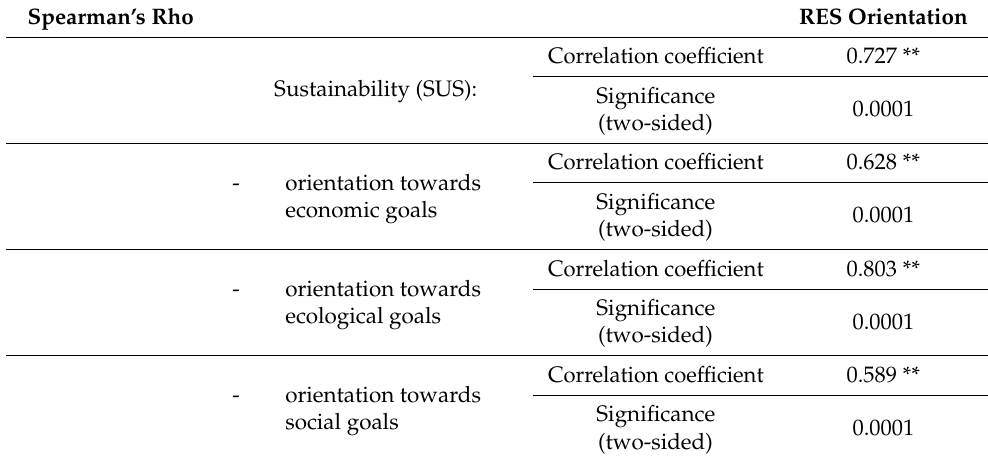
Table 8. Correlation between SUS and RES orientation ( n = 157).